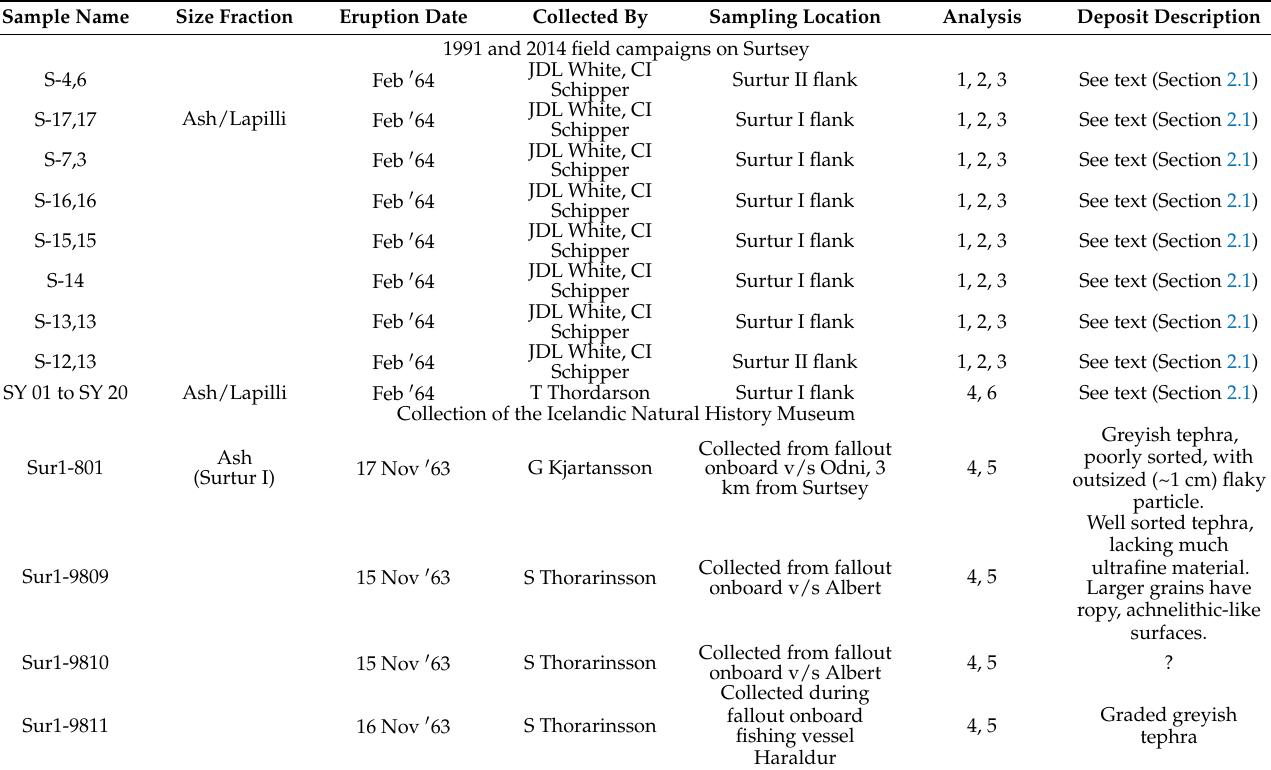
Table 1. List of samples used for this